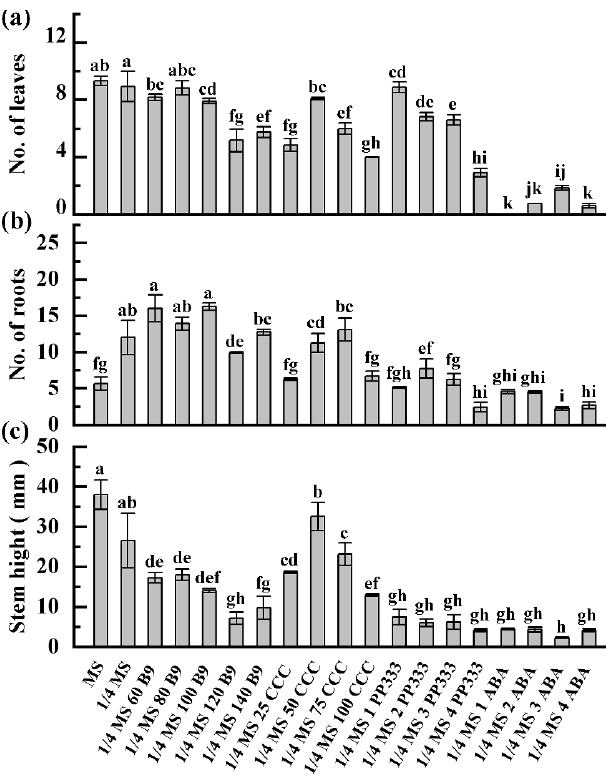
Figure 4. Growth status of ZHB plantlets incubated in slow-growth media. Data were surveyed 60 d post-culture. ¼ MS 60 B9 refers to ¼ MS medium supplemented with 60 mg/L B9, and so on. ( a – c ): Average plant height, number of new leaves, and number of new roots of potato ZHB, respectively. Data are presented as means ± SE. Significant differences were analyzed as one-way ANOVA at p < 0.05.